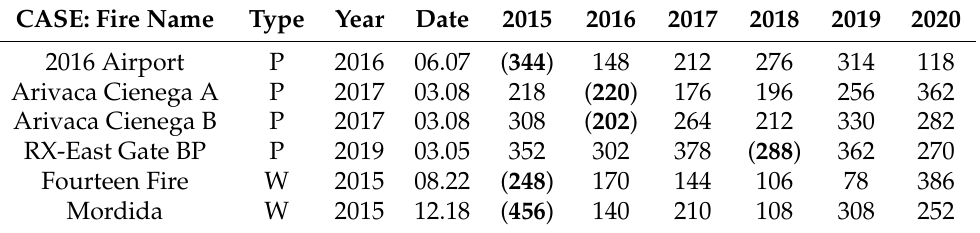
Table A2. The yearly estimated standard deviation ( σ ) of fine-fuels (kg/ha) within burn perimeters for wildfire (W) and prescribed (P) fires at BANWR, with parenthesized boldface values indicating pre- burn estimates prior to ignition (some ignition dates do not align with calendar date but rather to pre- or post-imagery dates) against 1-km buffered control (C) areas around fire perimeters (parenthesized italicized values reference ignition time period for unburned control